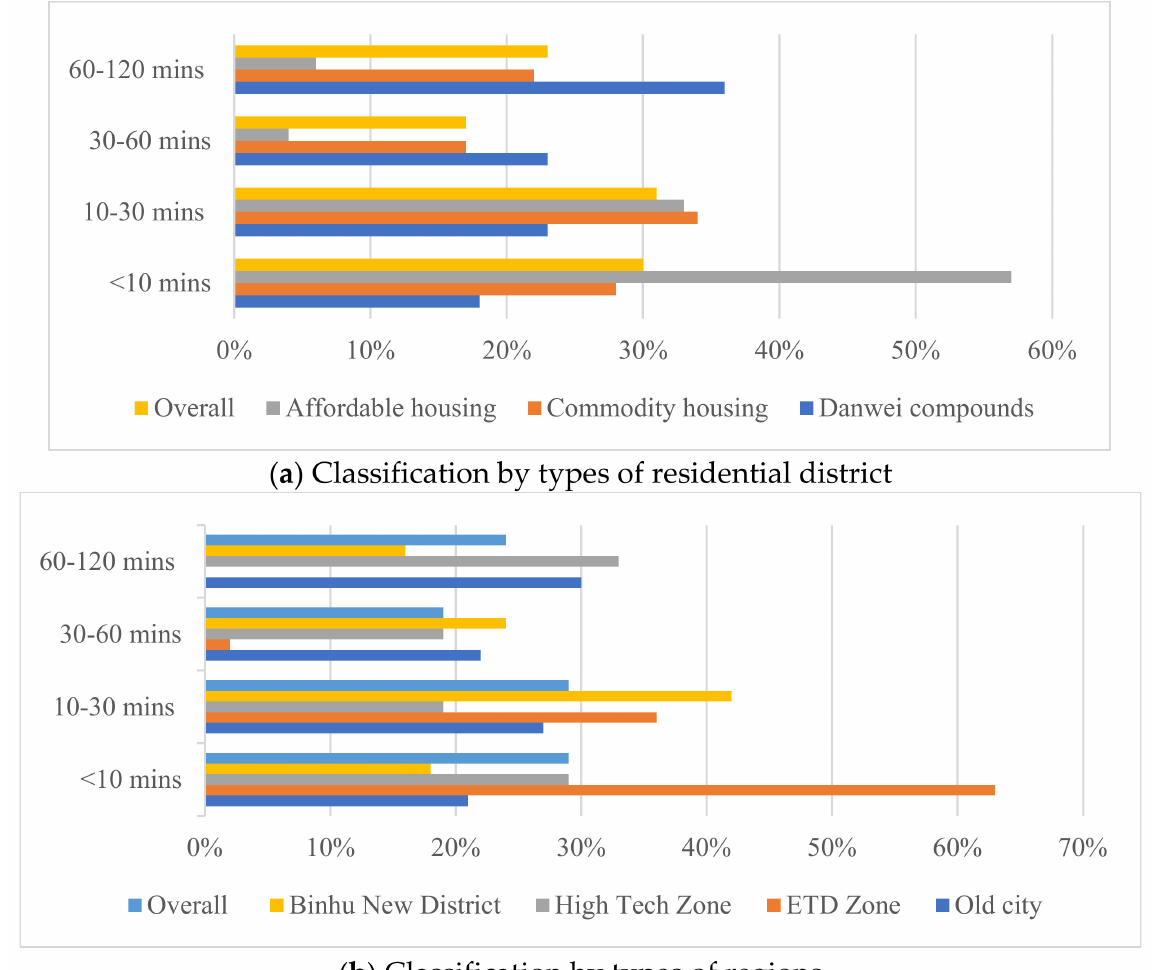
Figure 2. Statistical chart of leisure activity duration of the elderly in Hefei